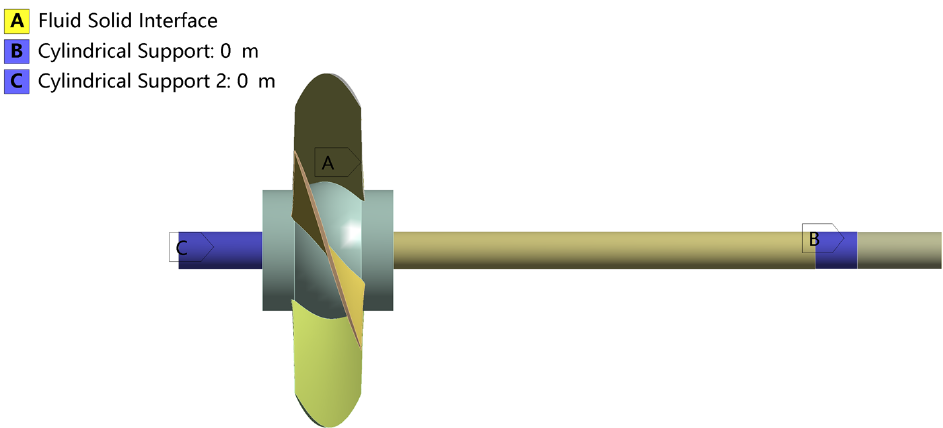
Figure 6. Boundary conditions of the structure calculation.